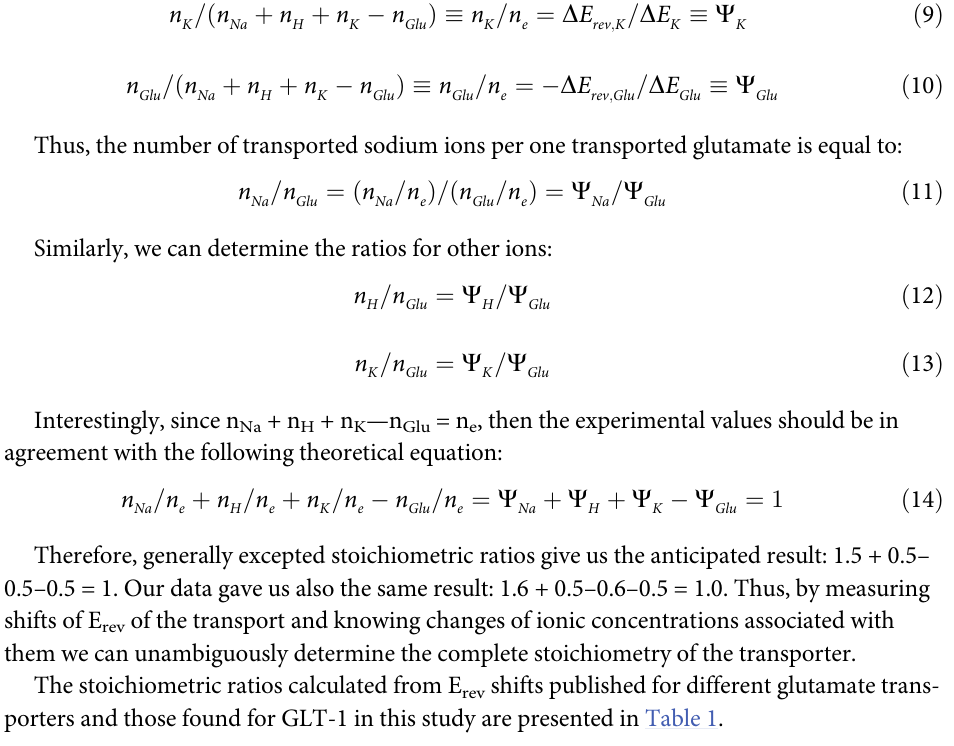
Table 1. Stoichiometric transport ratios of glutamate transporters in the absence of chloride that have been reported previously and found here. Transporter